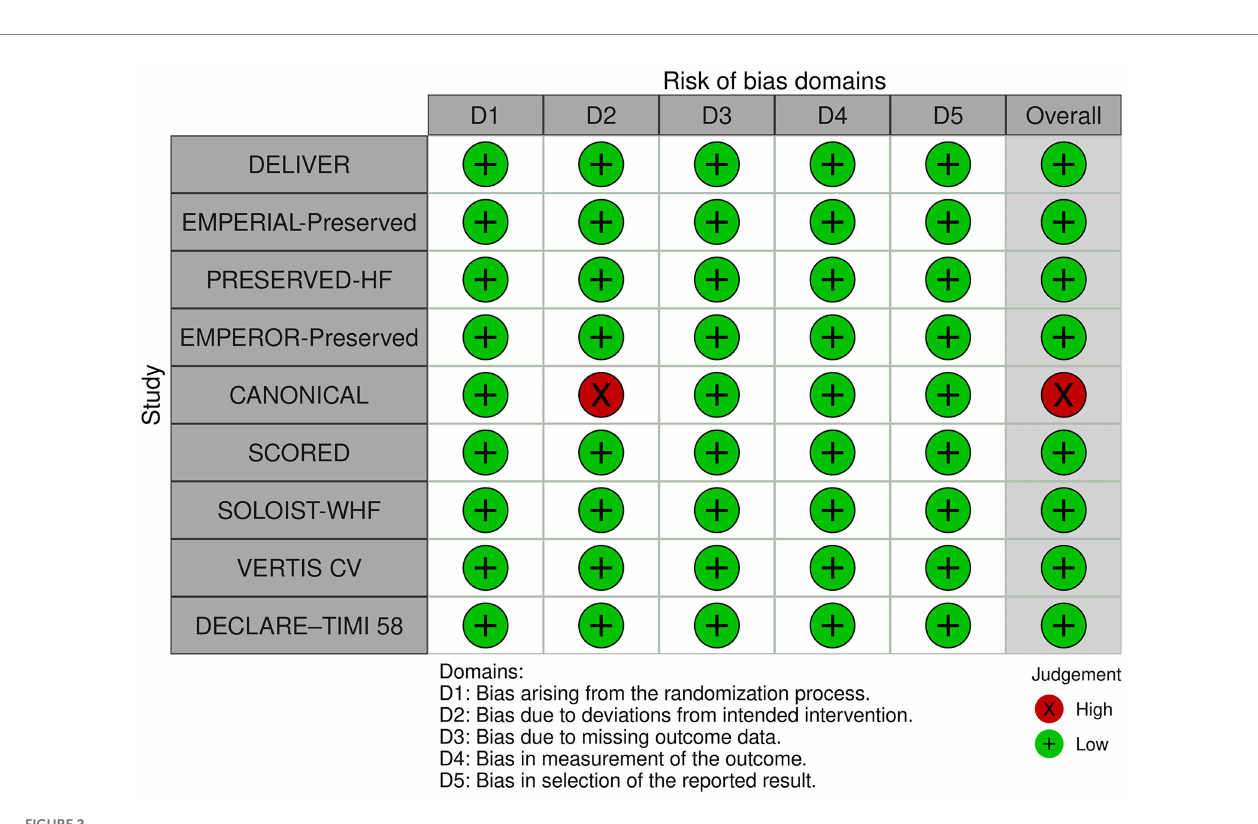
FIGURE 2 Quality assessment of the included randomized controlled trials using the Cochrane Risk of Bias 2